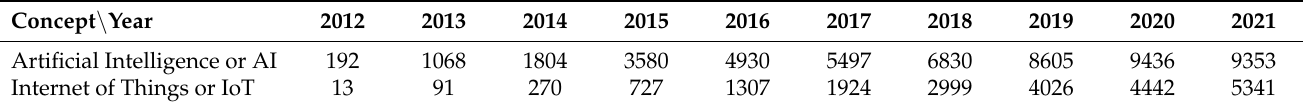
Table 5. The number of research publications related to Big Data per year for AI and